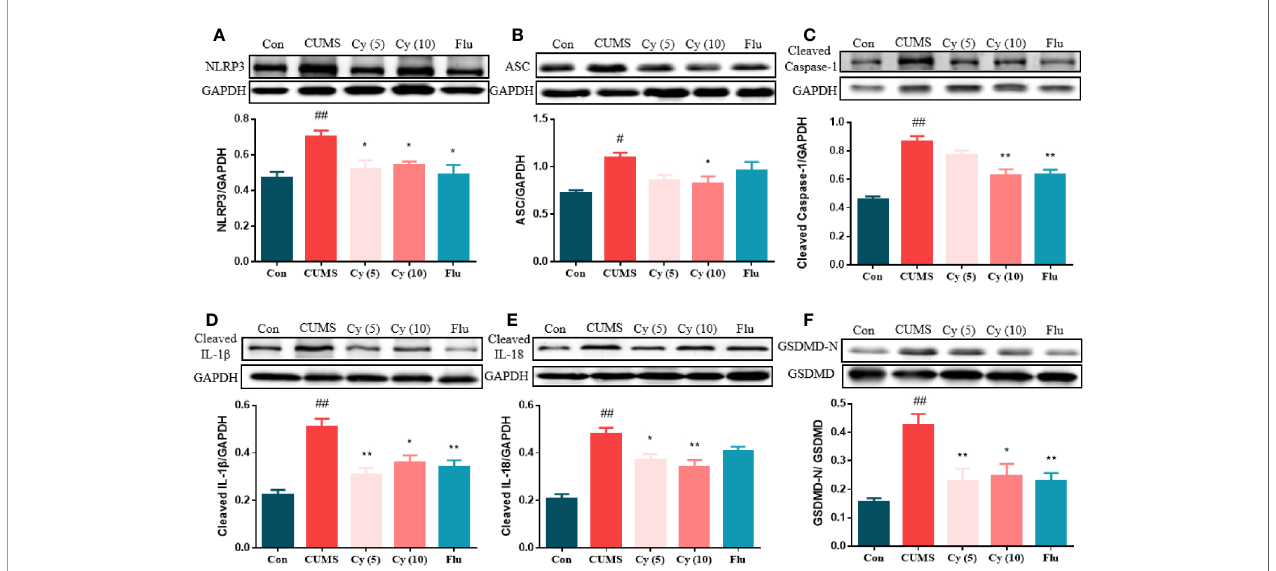
FIGURE 3 | Protein levels of the NLRP3 in fl ammasome in the hippocampus. Western blot was performed to measure the protein levels of NLRP3 in fl ammasome. The expression of NLRP3 in fl ammasome complex NLRP3 (A) , ASC (B) , Caspase-1 (C) were elevated, and cleavage of IL-1 b (D) , IL-18 (E) , and GSDMD (F) were activated after CUMS modeling. Cy treatment notably suppressed these expression. Data are represented as mean ± SEM. # p < 0.05 and ## p < 0.01 vs. Con group. * p < 0.05 and ** p < 0.01 vs. CUMS